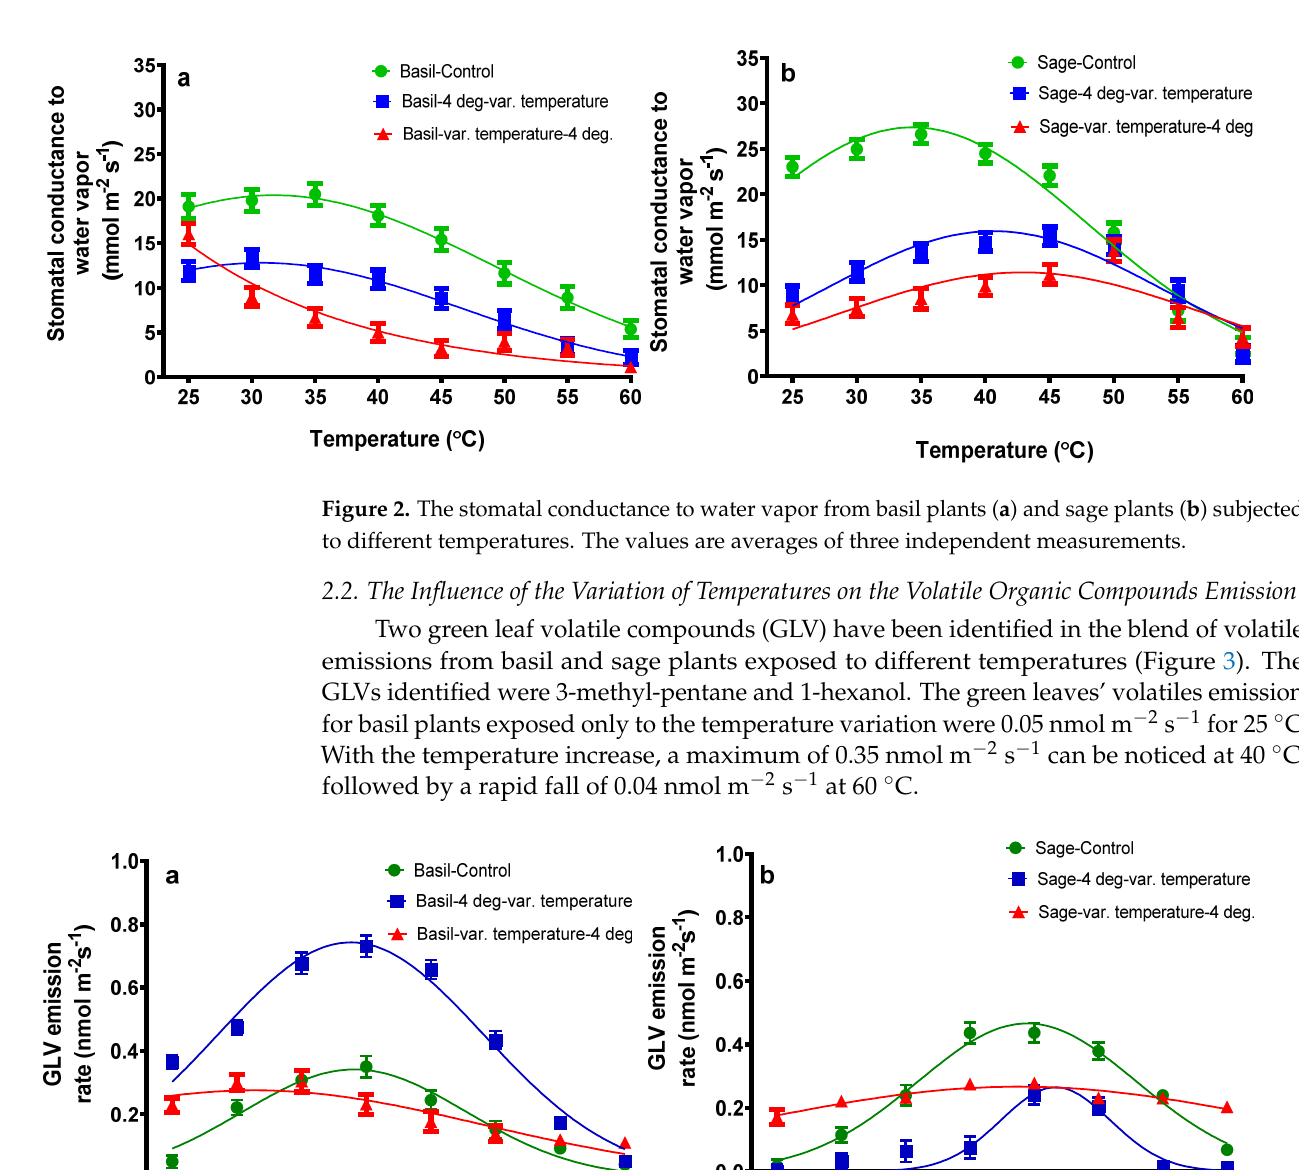
Figure 3. The emission rate of green leaf volatile compounds (GLV) from basil plants ( a ) and sage plants ( b ); plants were subjected to different temperatures.